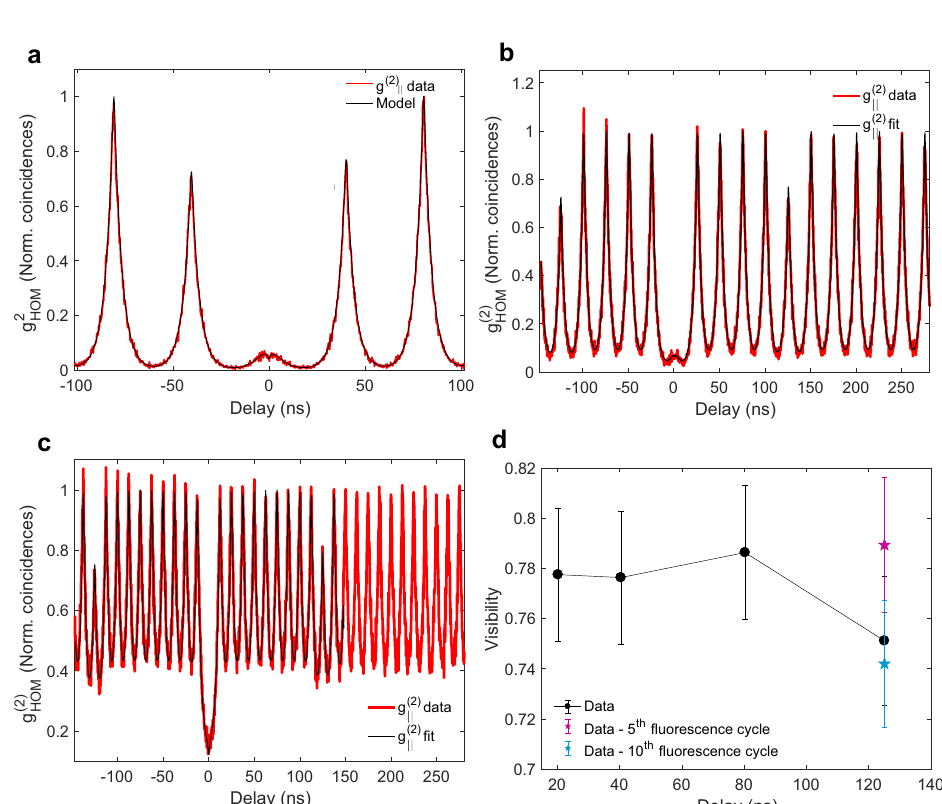
Figure 3. HOM Visibility: Quantum Interference Measurement of photons separated by (a)1 st (b) 5 th (c)10 th fluorescence cycles with 24.79MHz, 40MHz and 80MHz repetition rate, respectively. (d) HOM visibility as a function of Delay line with longest delay of